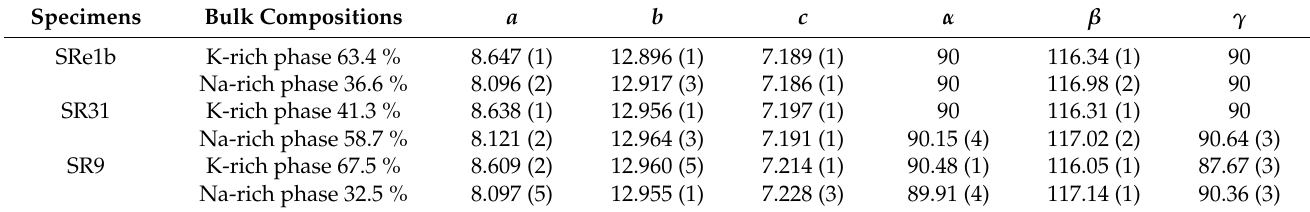
Table 8. Unit-cell parameters from Rietveld refinement of the three moonstone specimens: SRe1b, SR31 and SR9, in Å for the cell dimensions and degrees for the cell